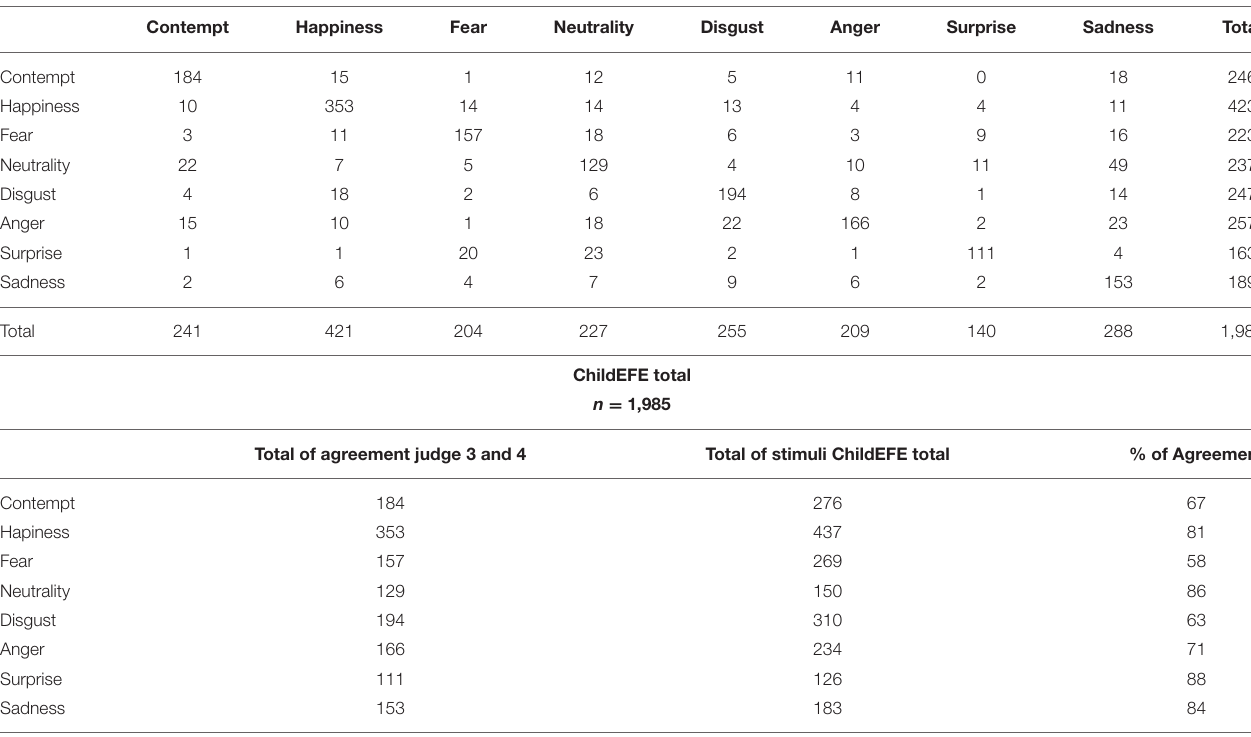
TABLE 5 | Number of stimuli evaluated for judge 3 and 4 of ChildEFES total